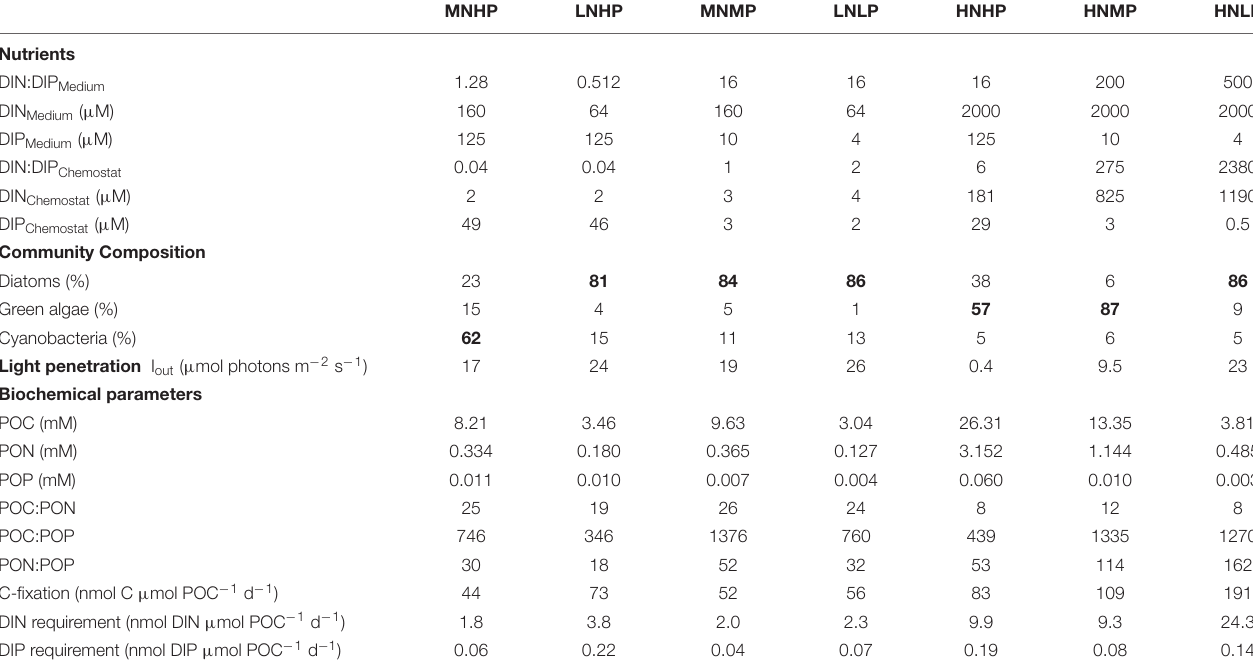
TABLE 1 | Concentrations and ratios of nutrients in the different media and in chemostats when phytoplankton communities reached steady state conditions. MNHP LNHP MNMP LNLP HNHP HNMP HNLP